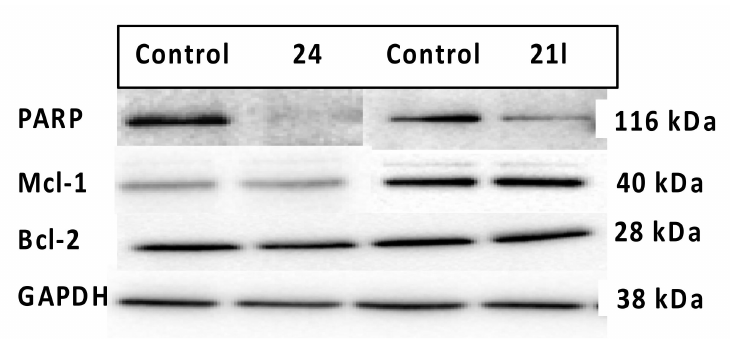
Figure 12. Effects of 21l and 24 on expression of PARP (poly ADP-ribose polymerase) and anti- apoptotic proteins Bcl-2 and Mcl-1. MCF-7 cells were treated with either vehicle control (ethanol, 0.1% v / v ) or with compounds 21l and 24 (1 µ M) for 24 h. After the required time, cells were harvested and separated by SDS-PAGE to detect the level of the apoptosis-related proteins. The membrane was probed with anti-PARP or anti-cleaved PARP antibodies. Results are representative of three separate experiments. To confirm equal protein loading, each membrane was stripped and re-probed with glyceraldehyde 3-phosphate dehydrogenase (GAPDH)